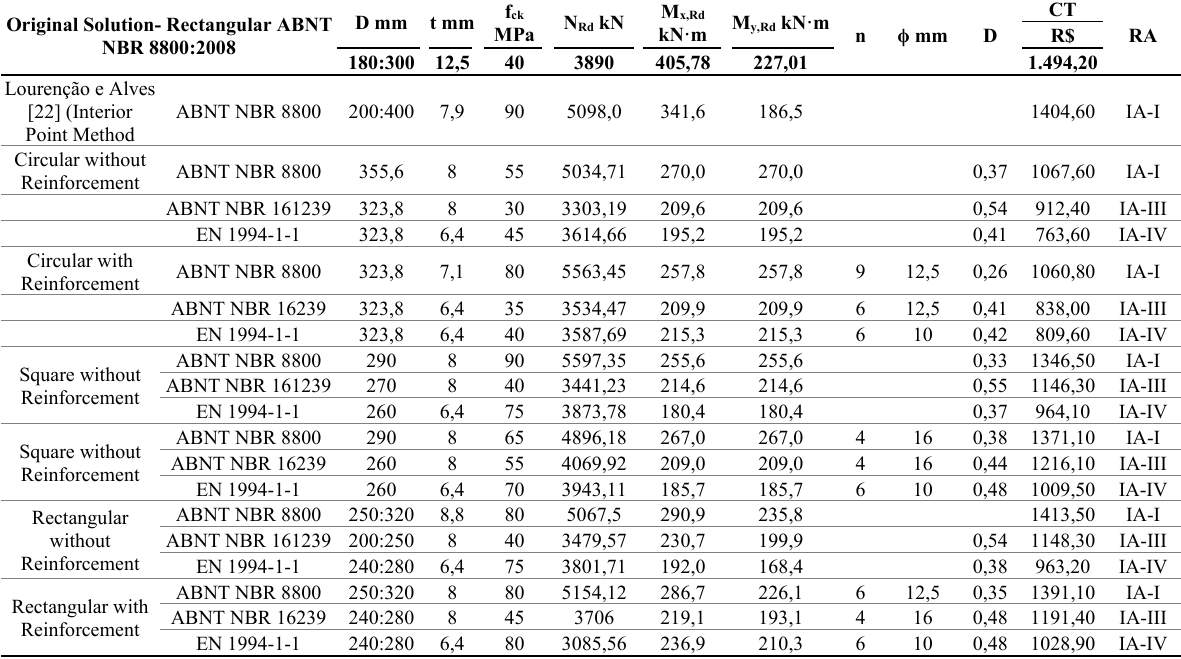
Table 6 – Optimization Results: L=3m; N Sd =1500kN; M x,Sd =132kN ⸱ m;M y,Sd =76kN ⸱ m Original Solution- Rectangular ABNT NBR 8800:2008